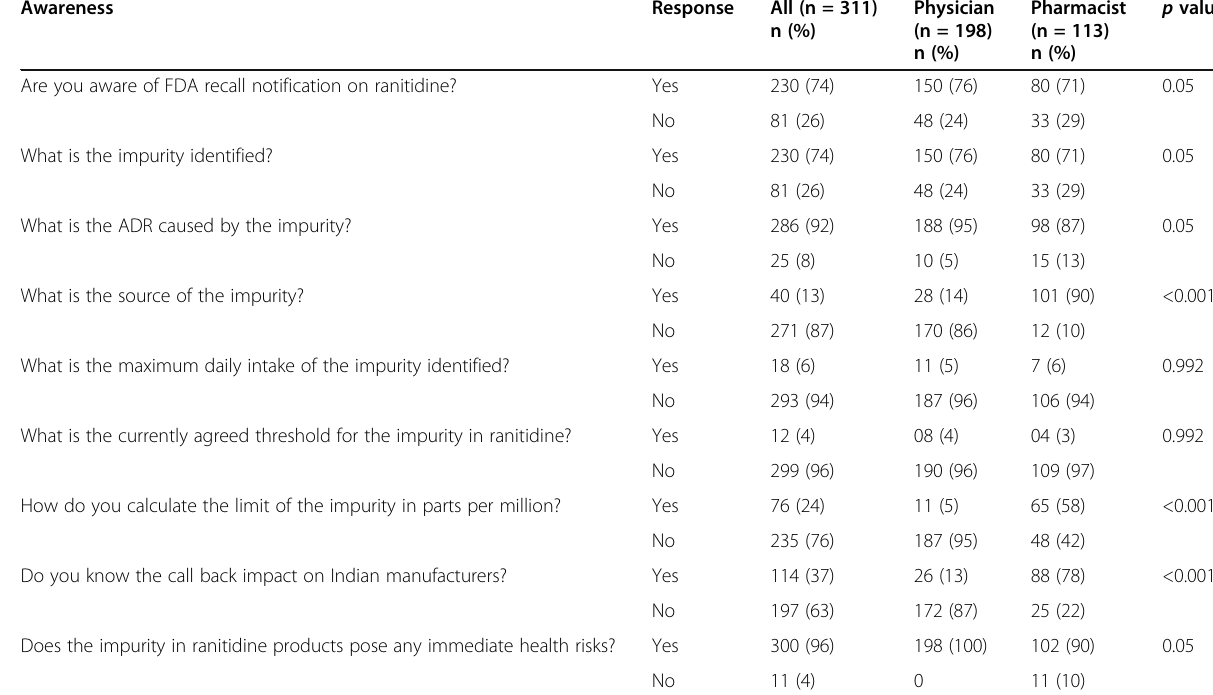
Table 2 Awareness about FDA announcement on voluntary recall of ranitidine and the issues